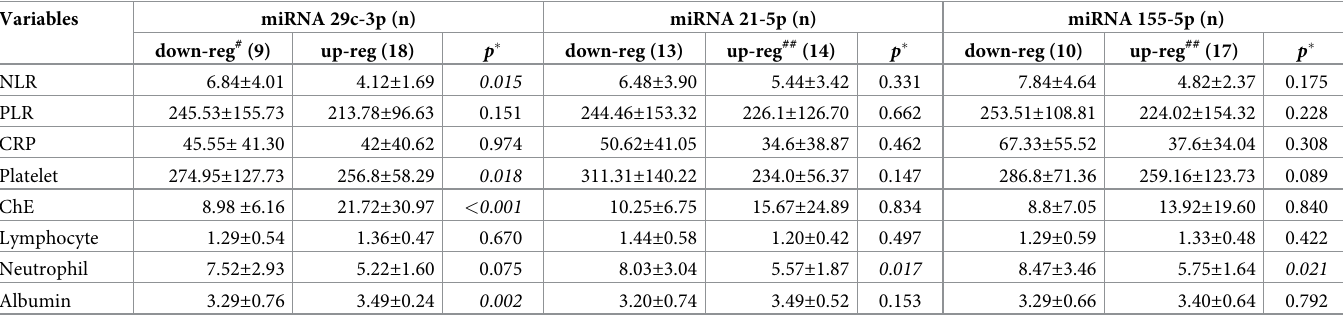
Table 4. The regulation of miRNA analyses based on clinical variables in 27 HCC patients. Variables